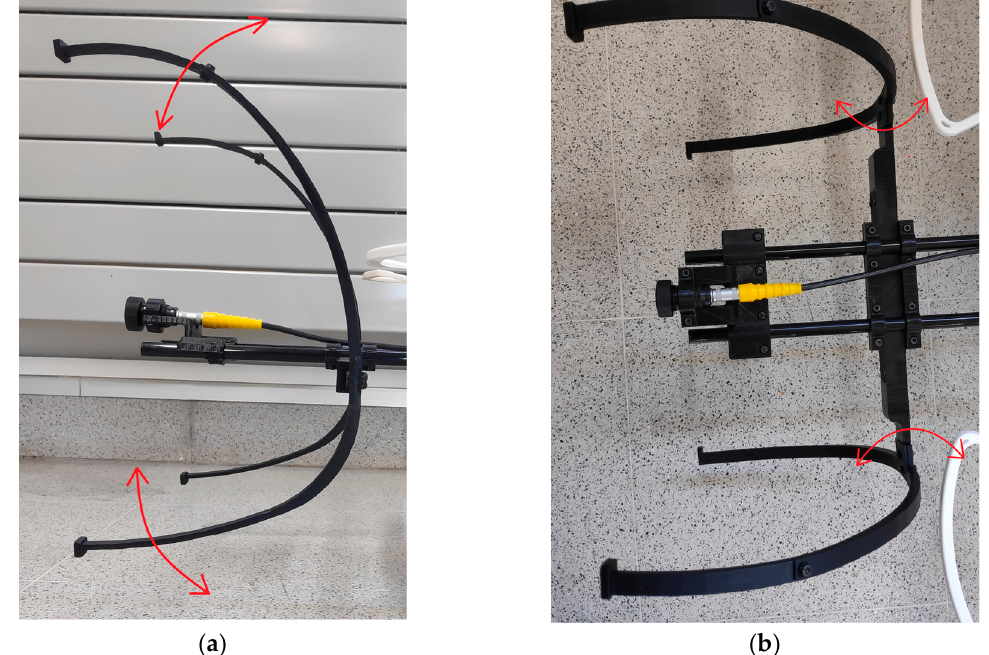
Figure 11. Flexible support legs for the contact with the bending movement (red arrows). ( a ) Side view. ( b ) Top view.